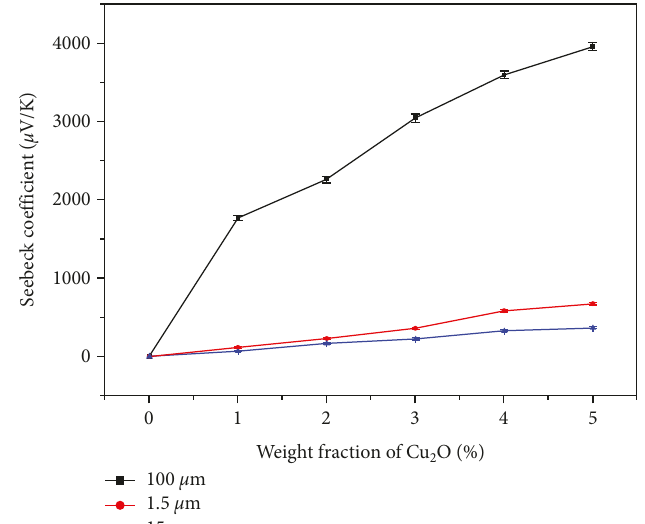
Figure 8: Relationship between the Seebeck coefficient of cement composites and weight fraction of added Cu particle